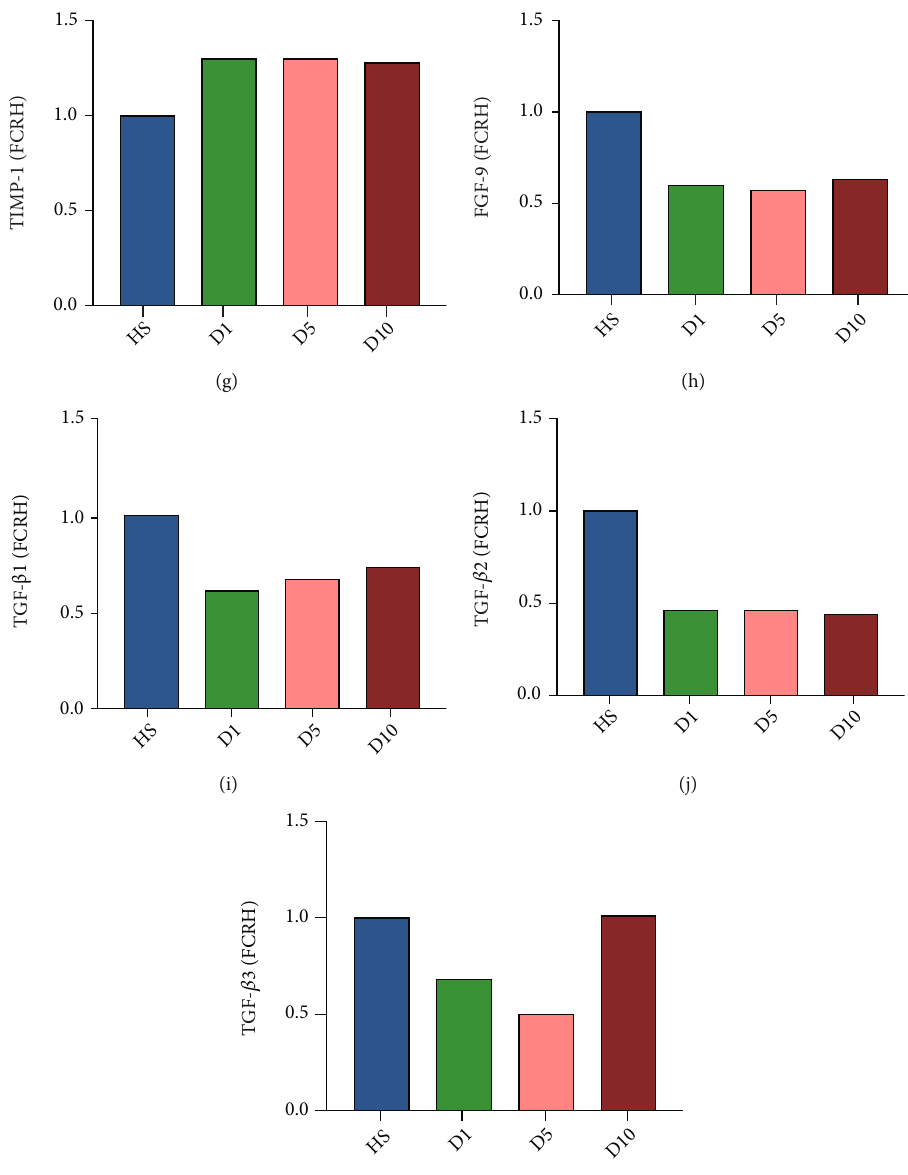
Figure 1: Results of the multicytokine array. (a) Heat map depicting the changes in cytokine levels in pooled serum from patients at day 1 (D1), day 5 (D5), and day 10 (D10) after polytrauma relative to cytokine levels in serum from healthy controls. The data are normalized by Z -score ( HS = 0 ) and analyzed by fold change relative to healthy serum (FCRH). A Z -score of 0 is represented by white color, a Z -score of 2.5 by red color, and a Z -score of -2.5 by blue color. Z -scores in between these values are depicted by less saturated colors of the same color palette. Cluster analysis was performed, and the cytokines were ordered accordingly. Some cytokines have an acute peak on the fi rst day after trauma, and some cytokines peak on the 5 th or 10 th day after trauma, but compared to HS, more than half of the cytokine levels decreased after trauma. The proin fl ammatory cytokines (b) interleukin- (IL-) 6 and (c) IL-8 as well as the anti-in fl ammatory cytokine (d) IL-10 were approximately four times higher at D1 in comparison to HS and two or three times higher when compared to D5 and D10. (e) Osteopontin was increased in the serum from all time points postpolytrauma as compared to serum from healthy donors. The increase in D1, D5, and D10 relative to HS was from six to twenty times. (f) Osteoprotegerin was higher only one day after polytrauma in comparison to HS with a fold change for about three times. (g) Tissue inhibitor of metalloproteinase (TIMP-1) was increased at all time points after polytrauma in comparison to serum from healthy controls. (h) Fibroblast growth factor 9 (FGF-9) was decreased in the polytrauma sera as compared to the HS.(i – k) Transforming growth factor-beta 1 (TGF- β 1), TGF- β 2, and TGF- β 3 were all decreased in polytrauma serum at D1 and D5 as compared to healthy serum ( n = 1 , pooled samples out of 84